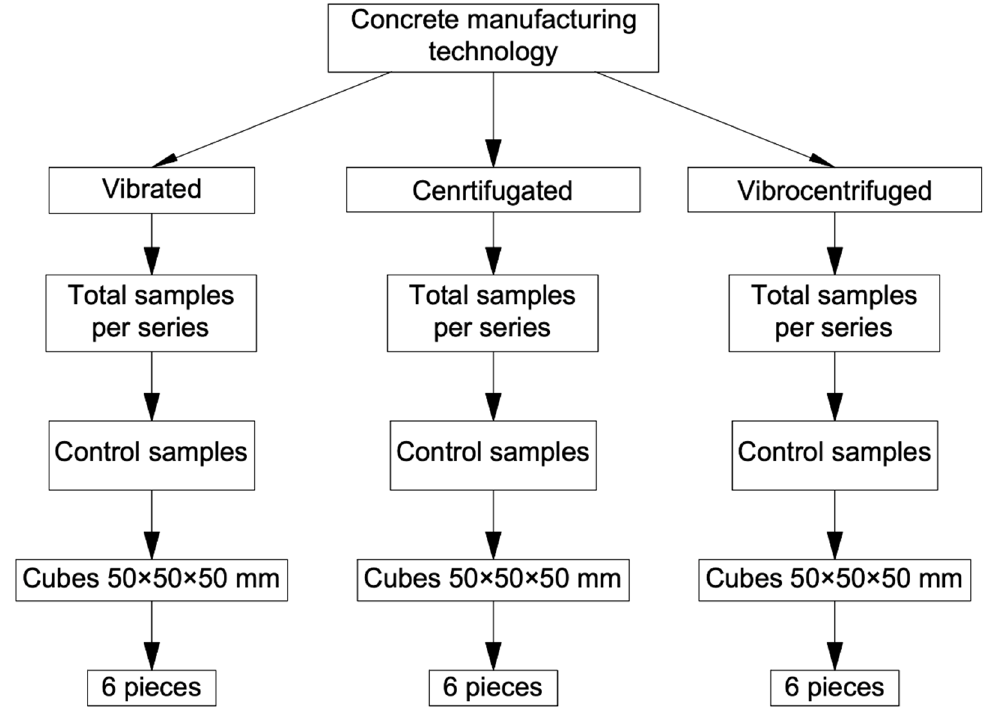
Figure 2. Experiment plan.